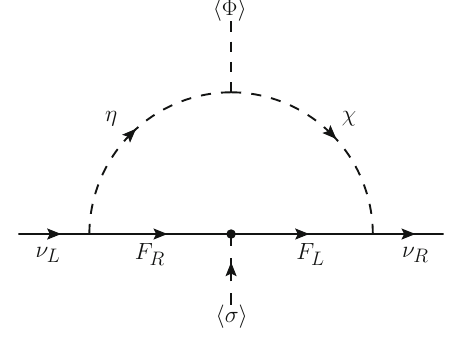
Fig. 1 One-loop generation of Dirac neutrino